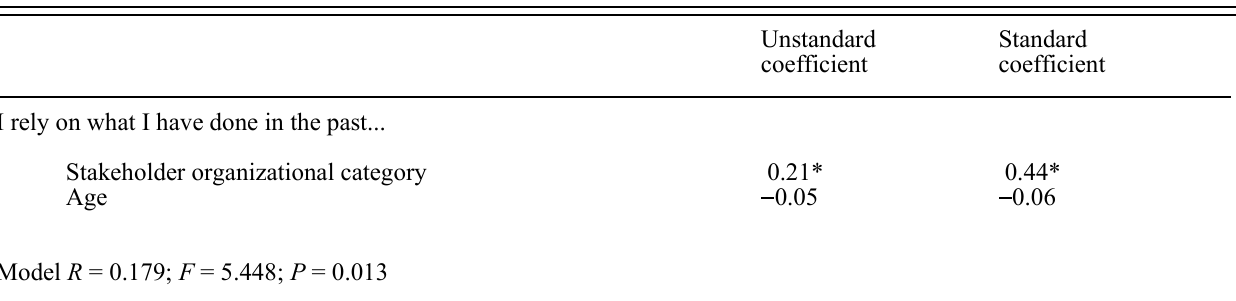
Table 2. Regression model for stakeholder category and land management